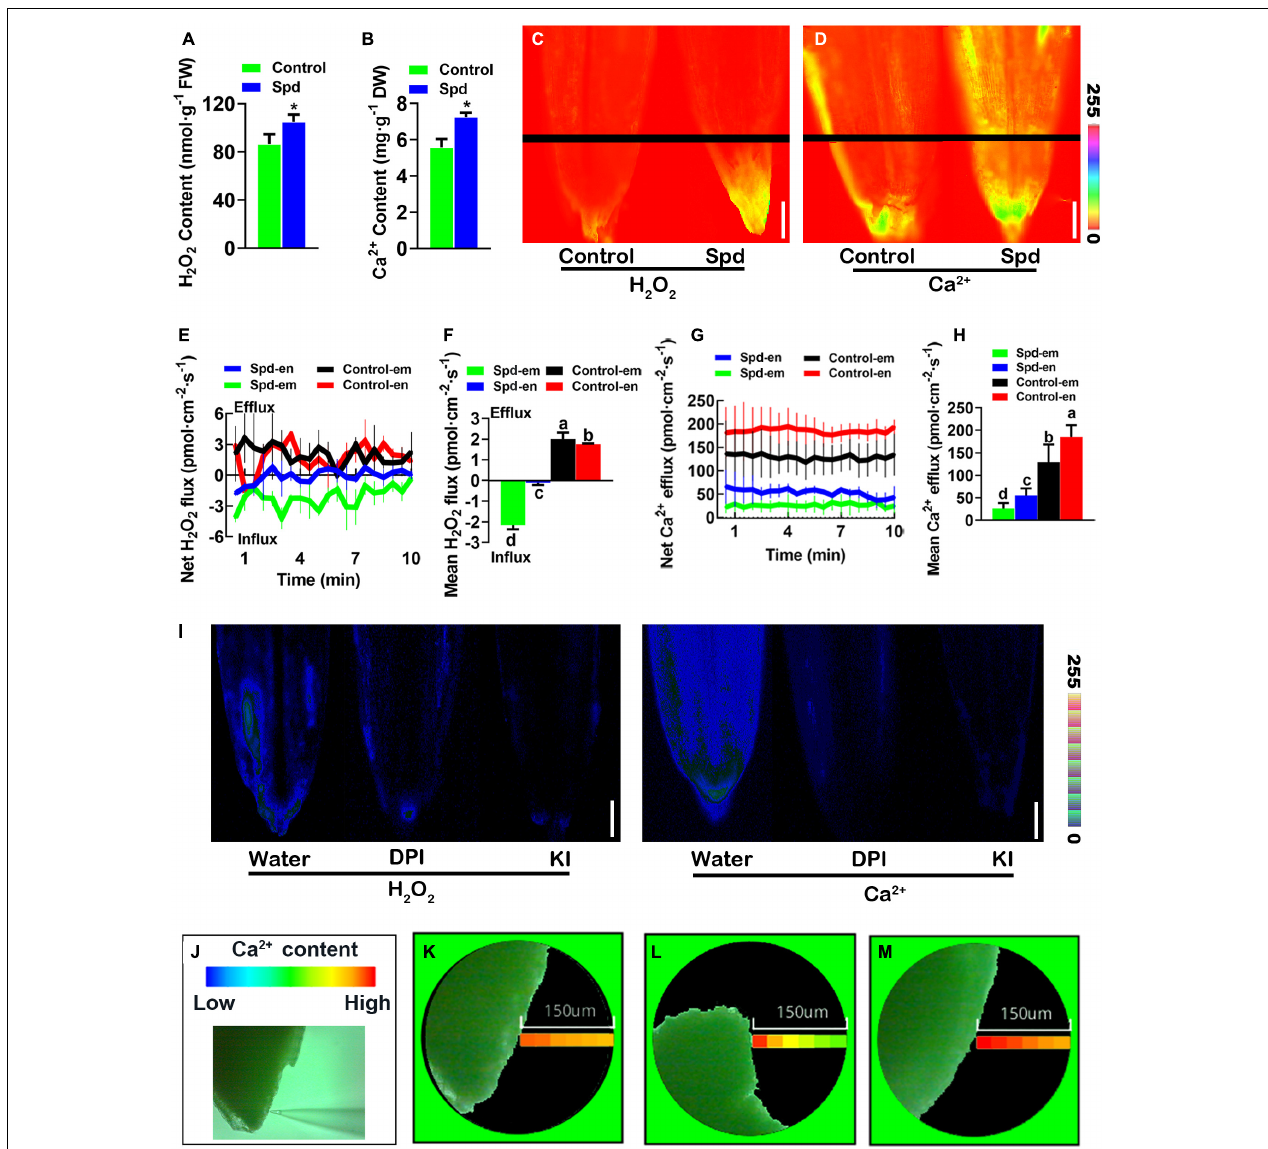
FIGURE 4 | Changes of cytoplasmic Ca 2 + and H 2 O 2 signals. (A) Content of H 2 O 2 . (B) Content of Ca 2 + . (C) Representative pseudo-color images, bar = 0.1 cm. (D) Representative pseudo-color images of embryo and endosperm, bar = 0.1 cm. (E) Transient net H 2 O 2 flux kinetics. (F) Mean rate of H 2 O 2 flux kinetics. (G) Transient net Ca 2 + flux kinetics. (H) Meant rate of Ca 2 + flux kinetics. (I) Representative pseudo-color images of embryo and endosperm, bar = 0.1 cm. (J) Detection of the spatial imaging of Ca 2 + concentration. (K) The spatial imaging of Ca 2 + concentration in the water treatment. (L) The spatial imaging of Ca 2 + concentration in the DPI treatment. (M) The spatial imaging of Ca 2 + concentration in the KI treatment. Vertical bars indicate mean ± SD ( n = 3), and * indicates a significant difference at the level of p < 0.05, and different small letters mean a significant difference at the level of p < 0.01.